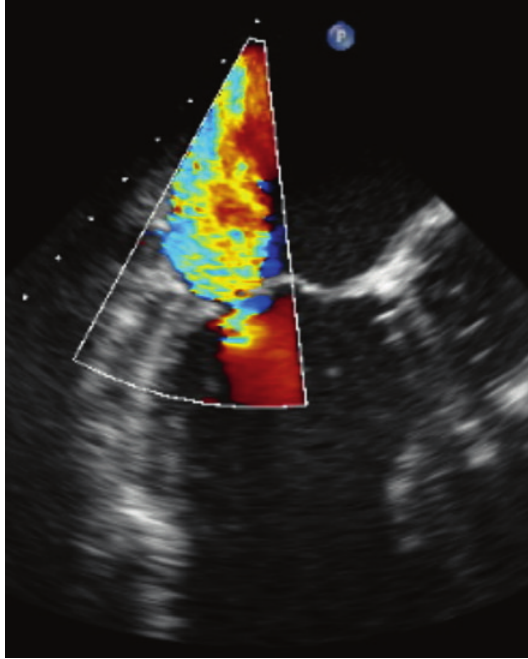
TEE long-axis view showing severe MR due to tethering of the posterior mitral leaflet (functional, ischaemic